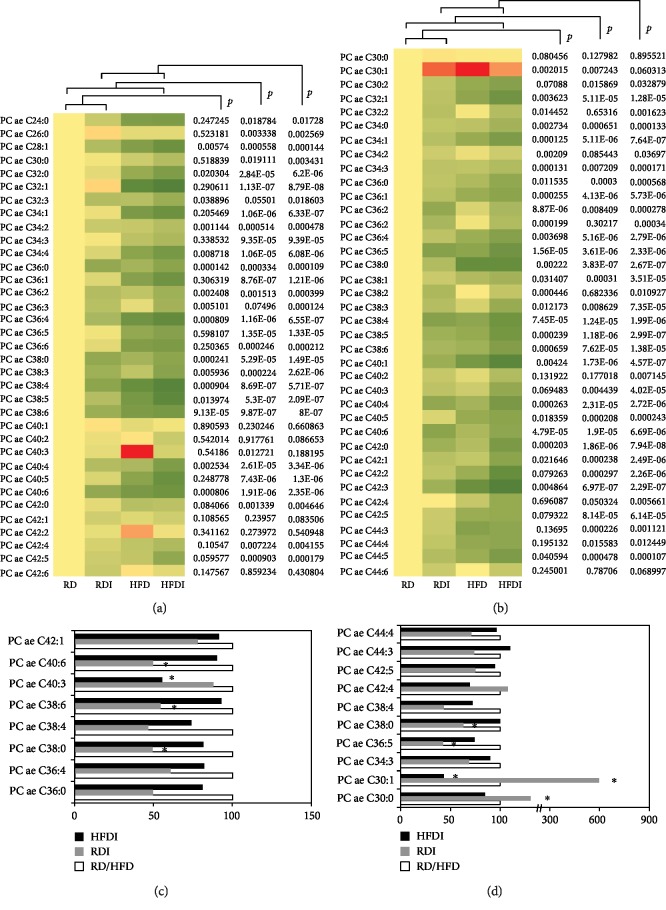
Comparison of phosphocholine (73) profiling between T. cruzi-infected and uninfected mice fed on different diets at 150 DPI. (a, b) Heat map representing the serum levels of various glycerol-phospholipids that included (a) diacyl PC and (b) acyl-alkyl PC during chronic infection in mice fed on either a RD or a HFD compared to uninfected RD mice at 150 DPI. Each row represents data for a specific metabolite, and each column represents the RD-fed uninfected (RD), RD-fed infected (RDI), HFD-fed uninfected (HFD), or HFD-fed infected (HFDI) mouse group. Different colors correspond to the different intensity level of metabolites (red > the control RD group and green < the control RD group). Statistically significant differences were tested using Student's t-test, and the corrected p values (q-value) are presented next to the heat map. Red, yellow, and green rectangles indicate high, moderate, and low expressions, respectively. (c, d) The percentage changes in the levels of phosphocholine metabolites that included (c) diacyl PC and (d) acyl-alkyl PC in infected mice compared to the respective diet-fed (RD and HFD) uninfected mice represented by a bar graph (∗significant change).